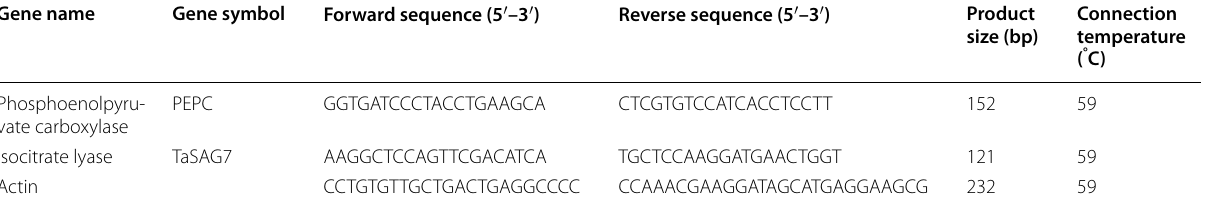
Table 2 Oligonucleotid primers designed for real-time PCR